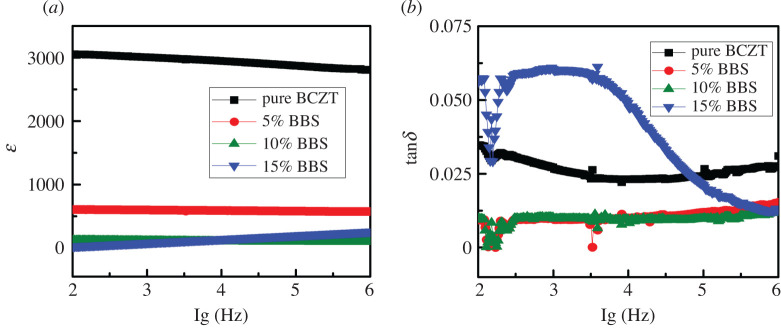
Frequency dependence of (a) dialectric constant and (b) dialectric loss for the (1 − x)BCZT-xBBS (x = 0, 0.05, 0.1, 0.15) glass ceramics.